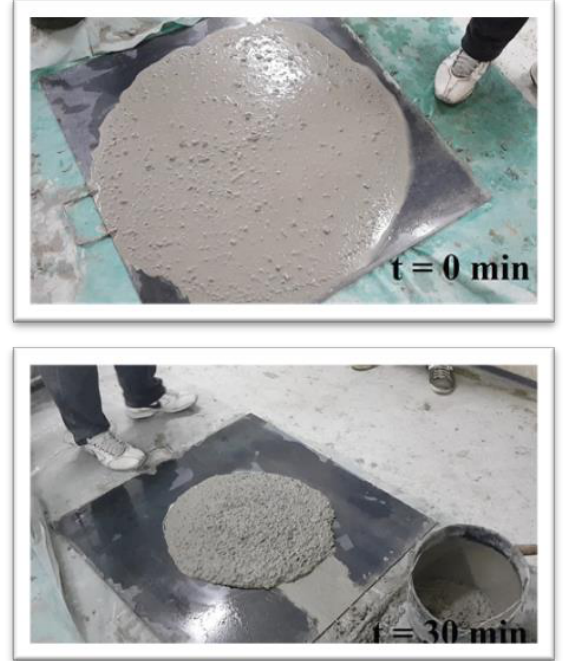
Figure 4. The decrease in workability of SCC characterized by slump-flow measurements immediately and 30 minutes after the